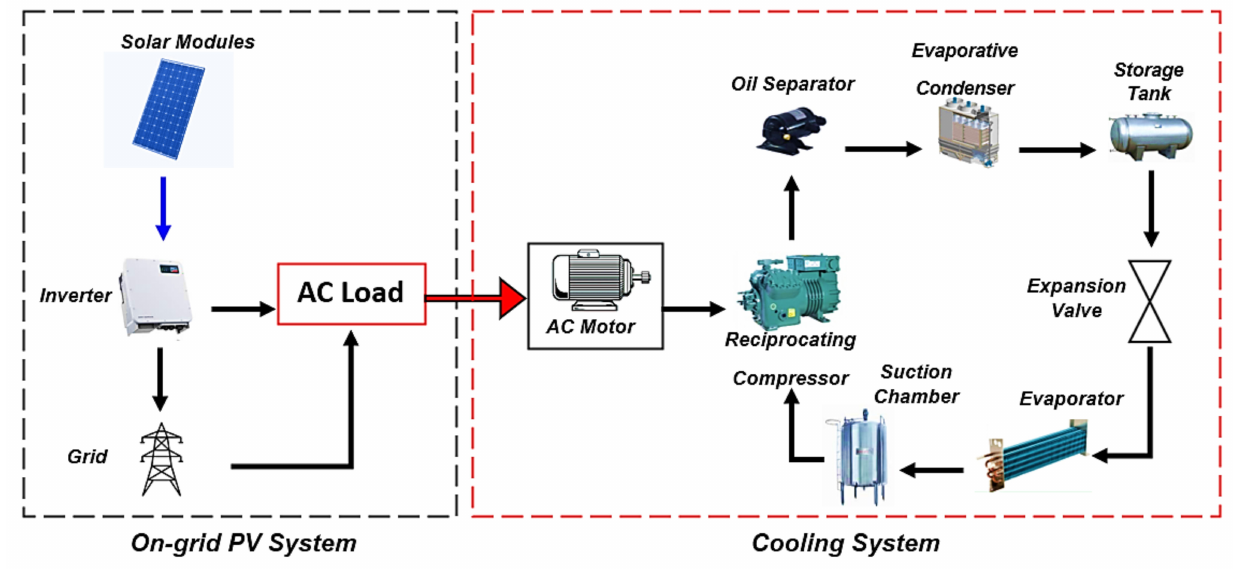
Figure 7. Schematic Diagram Energy System Cold